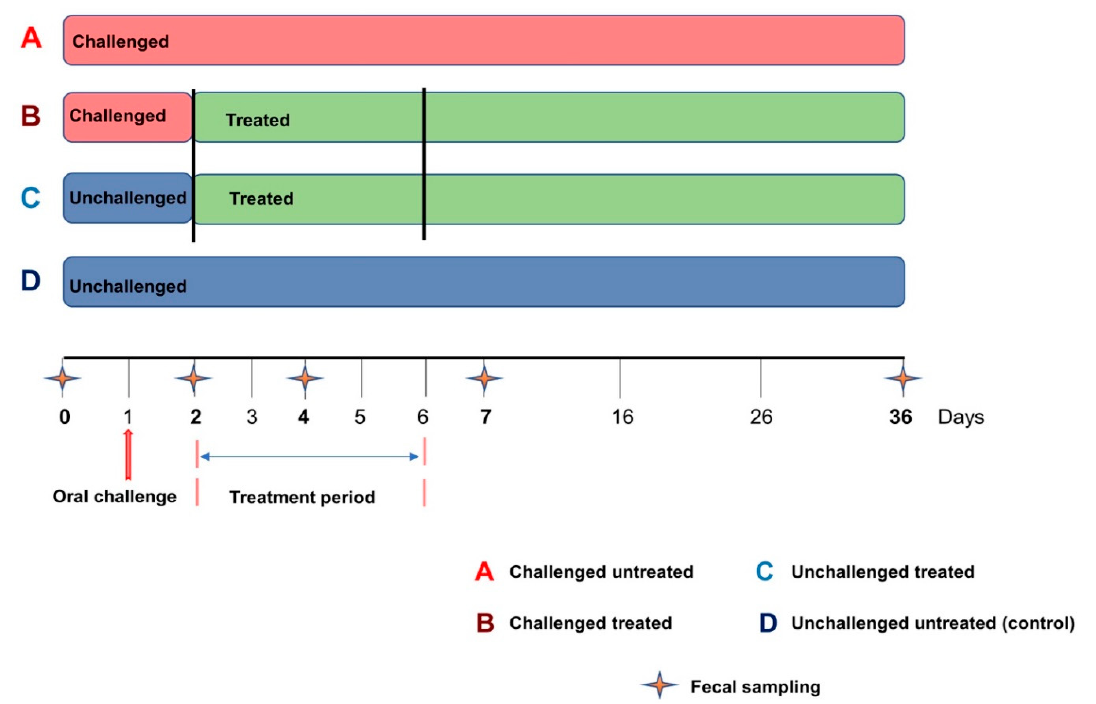
Figure 1. Experimental design. The challenge corresponded to the oral administration of 10 9 CFU of ETEC: F4 strain to each challenged piglet. The treatment period corresponded to the administration of colistin sulfate at the dose of 50,000 IU/kg twice a day, from Day 2 to Day 6.